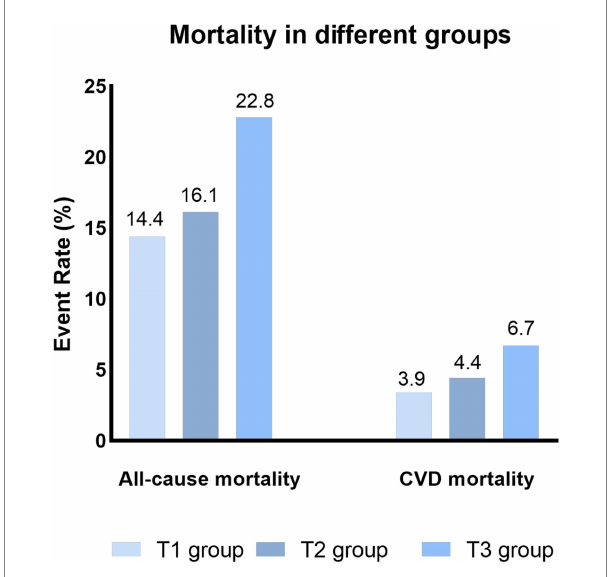
FIGURE 2 Kaplan–Meier survival estimates for long-term all-cause and CVD mortality (weighted).